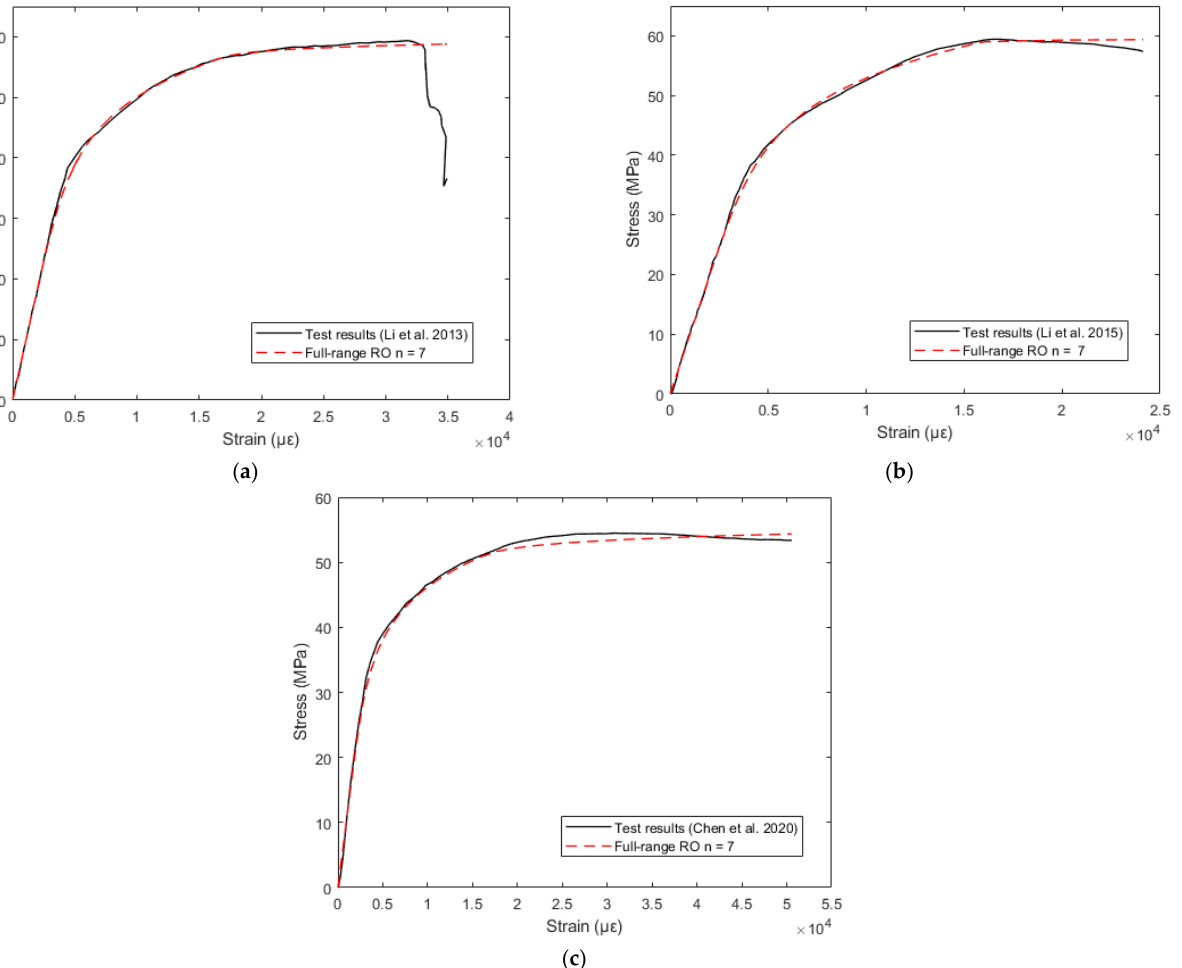
Figure 10. Stress-strain curves for LBL: ( a ) Li et al., 2013 [18], ( b ) Li et al., 2015 [34] and ( c ) Chen et al., 2020 [49].